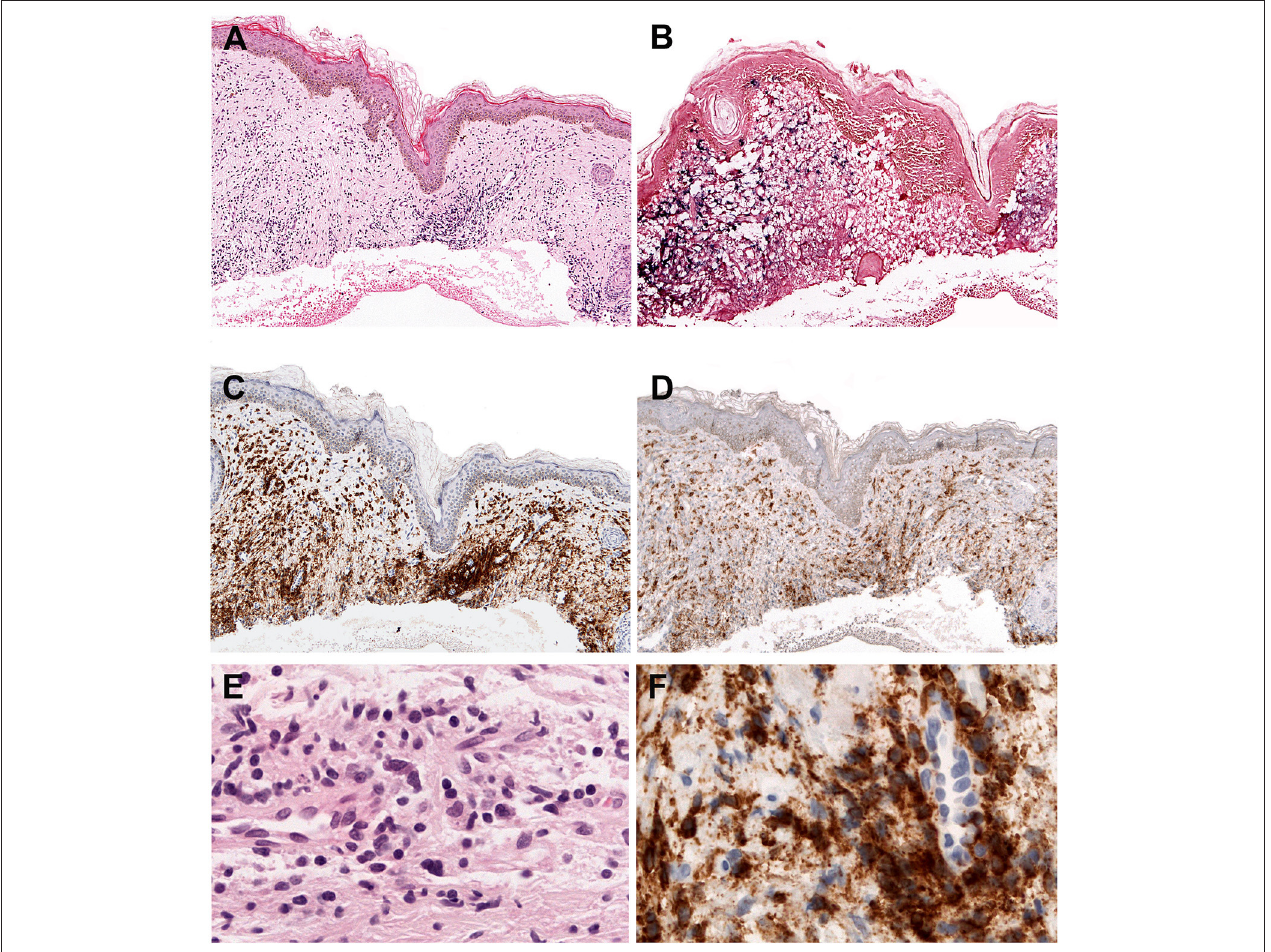
FIGURE 1 | Hydroa vacciniforme-like lymphoproliferative disorder. (A) A skin biopsy with a subtle dermal infiltrate surrounding adnexae and blood vessels (H&E, 25x); (B) The lymphoid cells are EBV positive, as demonstrated by in situ hybridization for EBV-encoded small RNA (EBER) ( in situ hybridization, 25x); (C) CD8 is positive in the majority of the infiltrating cells (immunohistochemistry, 25x); (D) The infiltrating cells are negative for CD4. CD4 highlights the abundant histiocytes (immunohistochemistry, 25x); (E) The infiltrating cells are predominantly small, without atypia (H&E, 400x); (F) The infiltrating cells are surrounding a blood vessel highlighted by CD8 stain (immunohistochemistry,